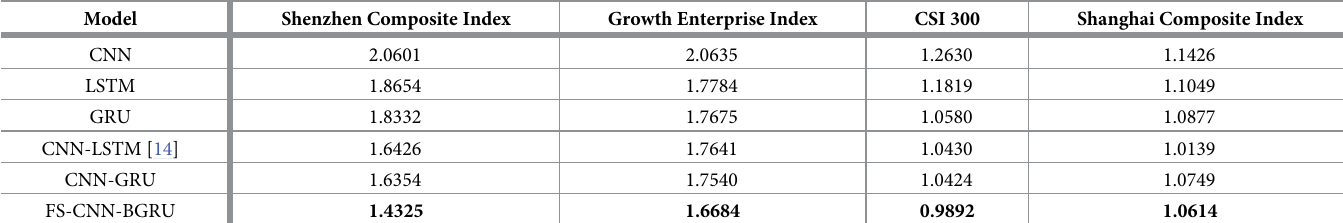
Table 11. MAPE value of index stocks (%).